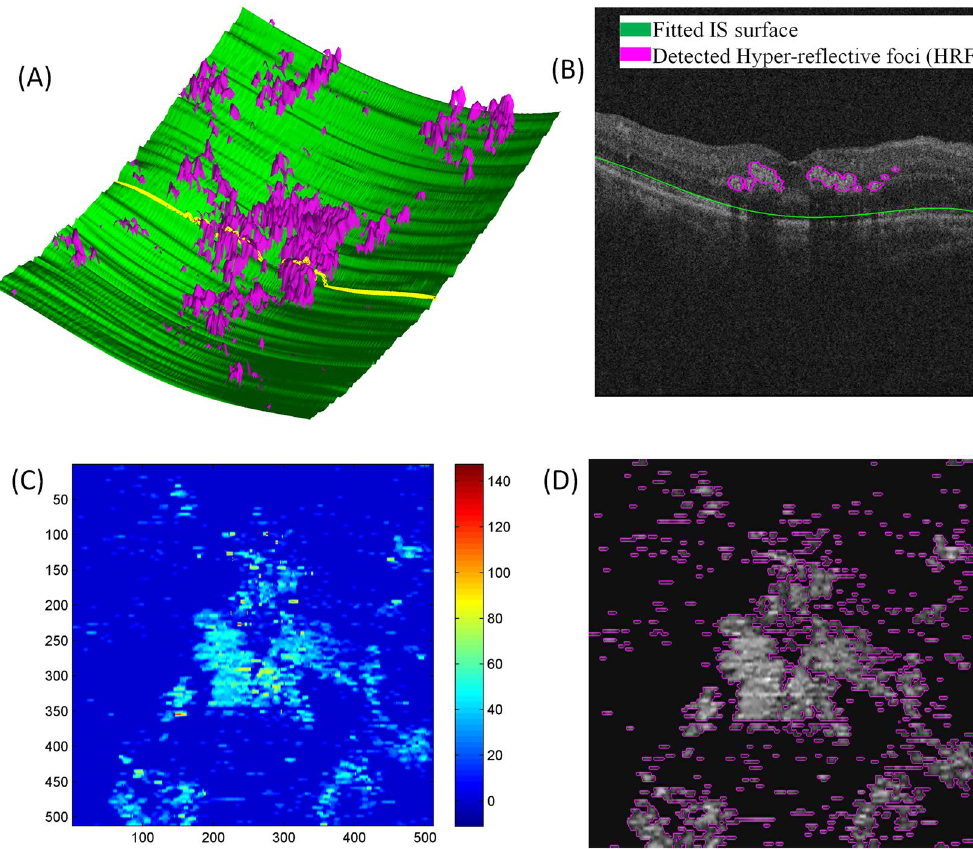
Figure 4. Hyper-reflective foci segmentation, ( A ) Hyper-reflective foci 3D surface view, where green and pink represent the fitted IS surface and the detected hyper-reflective foci, respectively. ( B ) Results from hyper- reflective foci segmentation in an example of a B-scan, corresponding to the yellow line in ( A ). ( C ) Generated hyper-reflective foci topographic height map and ( D ) Topographic height map